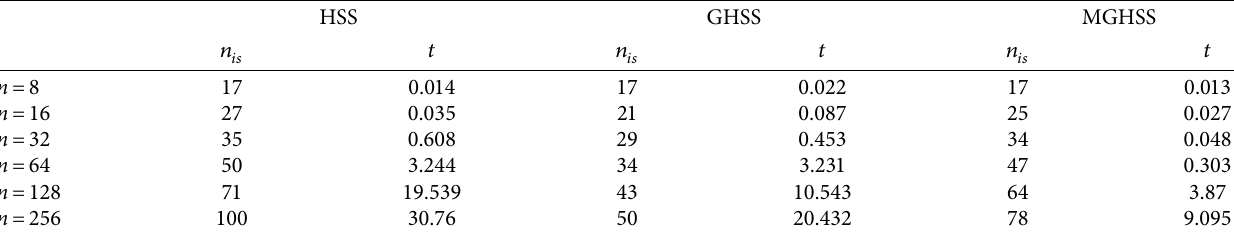
Table 6: Comparison of IMGHSS and MGHSS in terms of n IMGHSS MGHSS n t n is